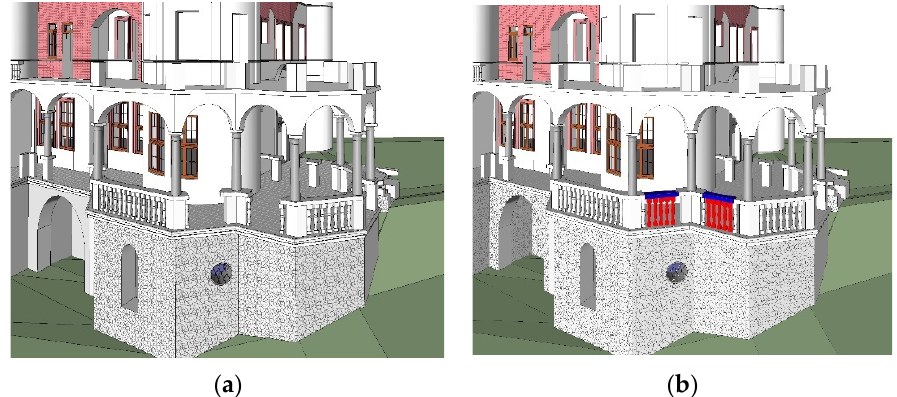
Figure 14. Original ( a ) and refurbished ( b ) baluster.